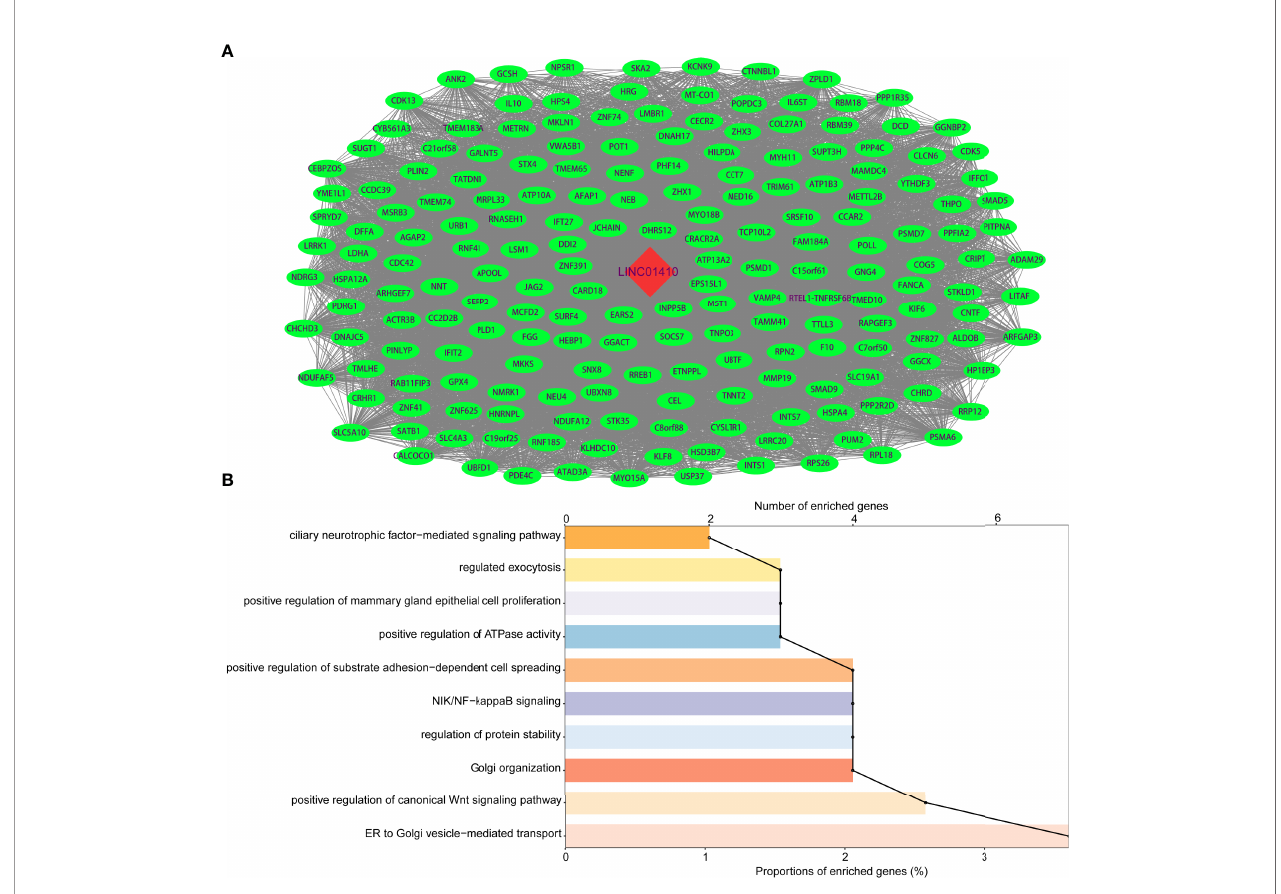
FIGURE 4 | Functional enrichment analysis of protein-coding genes co-expressed with LINC01410. (A) Network of protein-coding genes co-expressed with LINC01410 in GBC. Red nodes represented LINC01410, and green nodes represented LINC01410-correlated PCGs. (B) GO enrichment terms signi fi cantly associated with protein-coding genes in